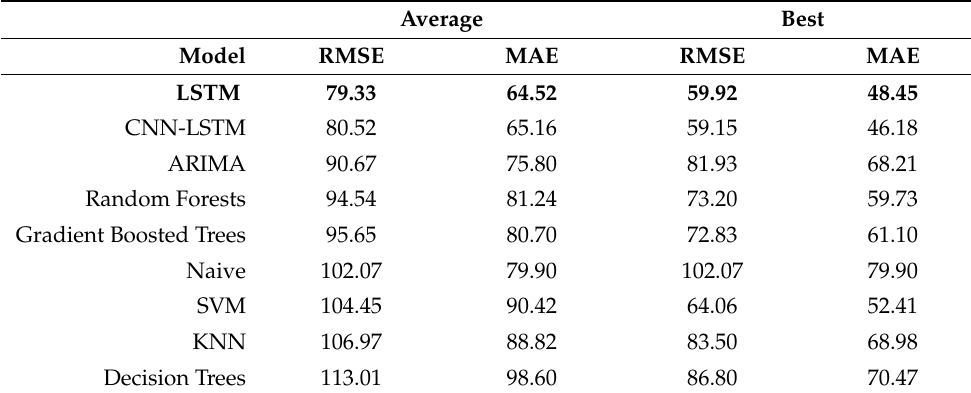
Table 1. Error metrics on average and of the best hyperparameter configurations.